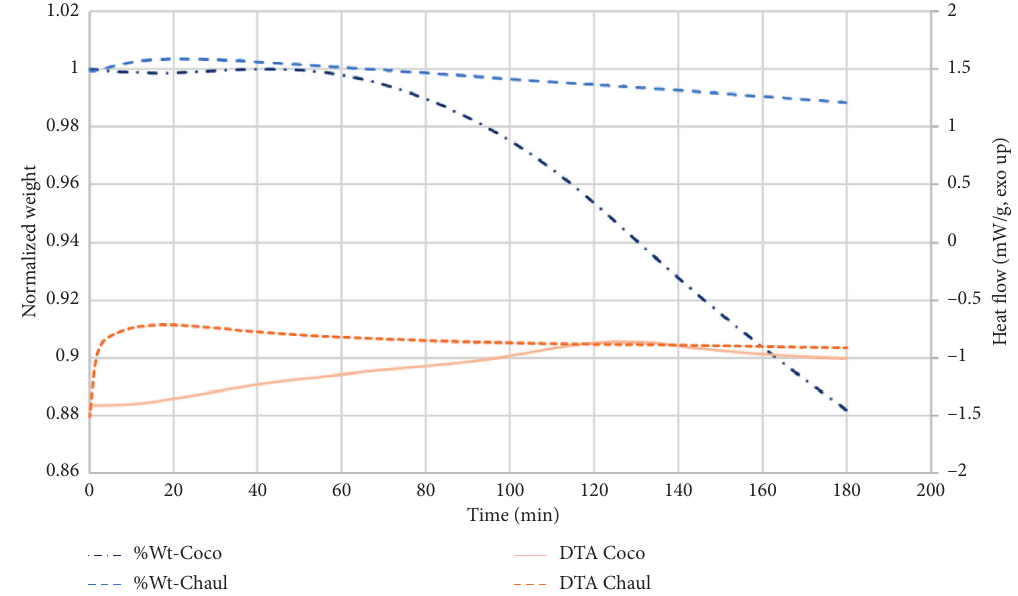
Figure 17: Isothermal TGA/DTA of chaulmoogra oil and coconut oil in